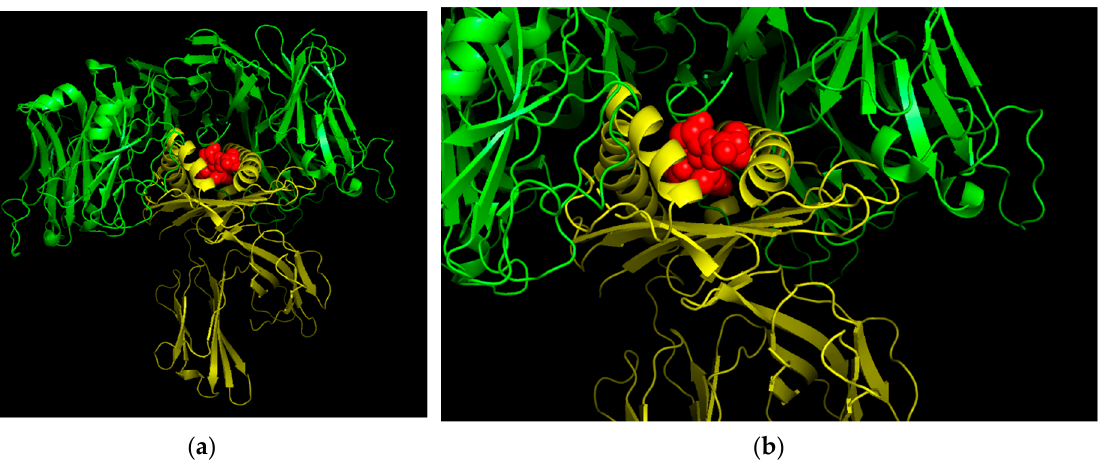
Figure 9. Three-dimensional structure of T36-5 TCR specific for HLA-A68. The TCR is modelled in green, the HLA allele is modelled in yellow, and the peptide is modelled in red. The HLA-peptide complex has been superimposed onto the TCR. ( a ) provides a full view of the TCR-MHC complex. ( b ) provides a zoomed in view of the complex that focuses on the MHC-peptide complex superimposed onto the TCR.